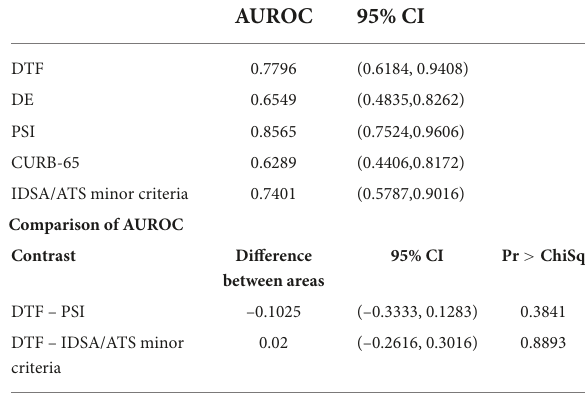
TABLE 3 Area under the receiver operating characteristic curve (AUROC) analysis of risk stratification tools in predicting development of respiratory failure.